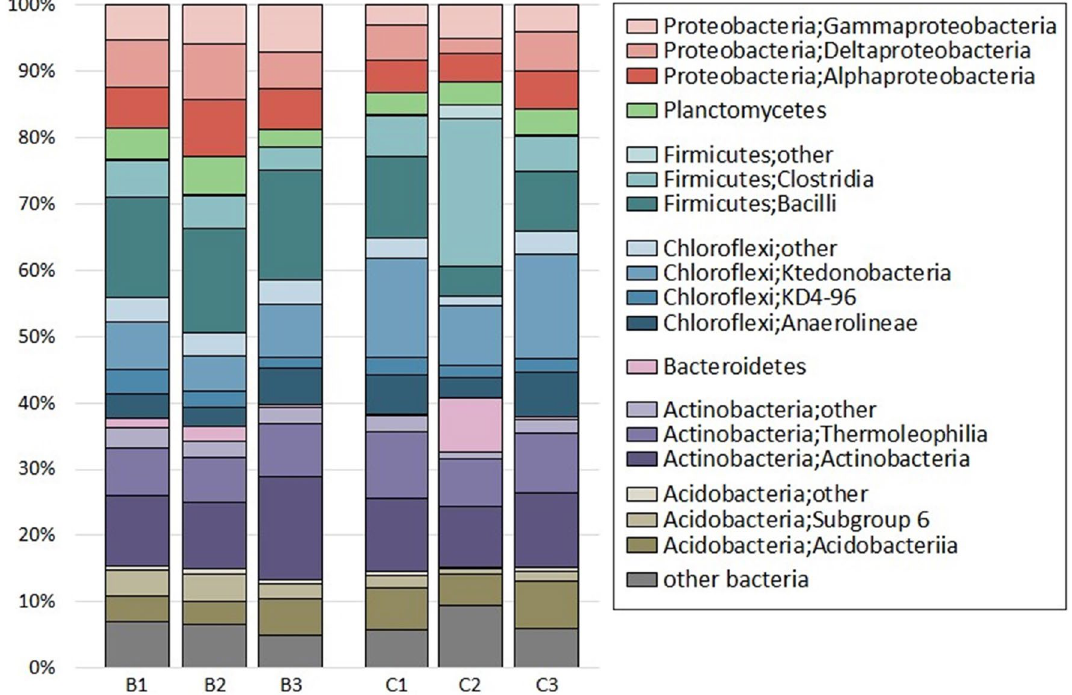
Figure 2. Bacterial class–phyla distribution profiles of microbial diversity between soil with and without biochar (B1–B3 and